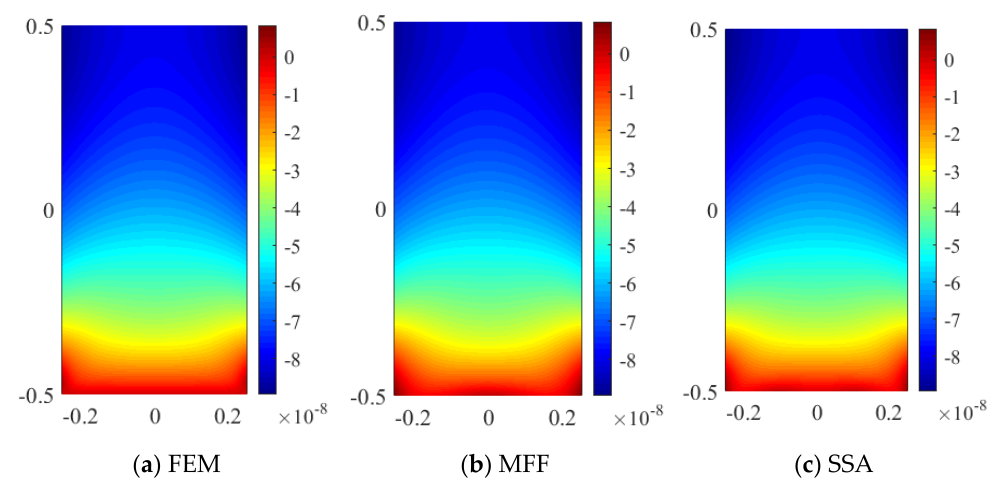
Figure 9. Displacements of u 2 calculated by the FEM and improved RBFCM.